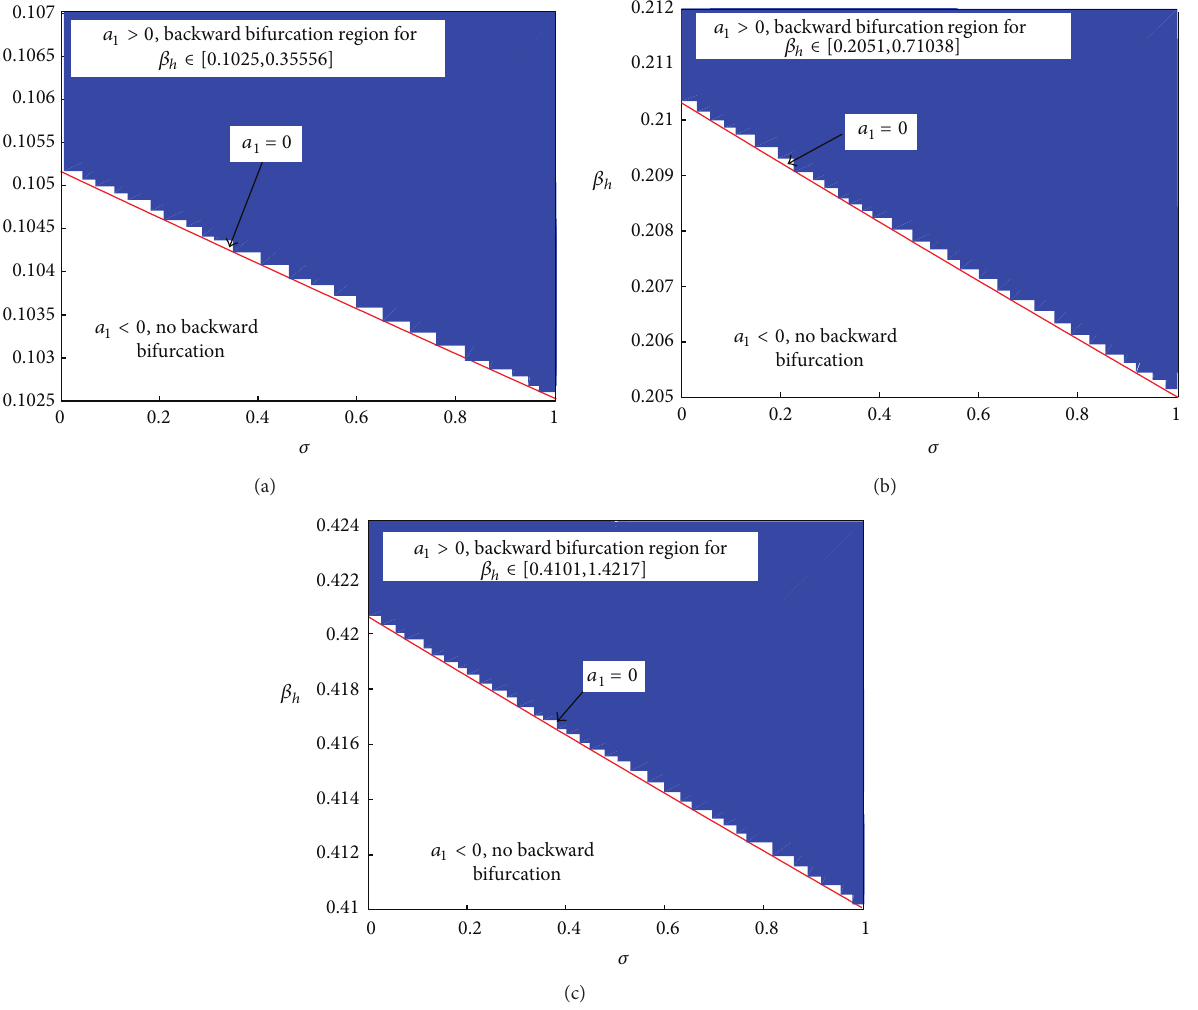
Figure 4: Backward bifurcation regions for the model (4) in the 𝜎 - 𝛽 ℎ parameter space corresponding to 𝜎 = 1 and various ranges of 𝛽 ℎ . Parameter values used are: Λ ℎ = 30, Λ 𝑣 = 24, 𝛿 ℎ = 0.2, 𝛾 ℎ = 0.0005, 𝜇 ℎ = 0.00004, 𝑏 = 0.4, 𝜇 𝑣 = 0.0.015, 𝛽 𝑣 = 0.09 . In (a) 𝜇 𝑣 = 0.05, ℜ 0 = 0.0014046 (backward bifurcation region for 𝛽 is 𝛽 ℎ ∈ [0.2051, 0.71083]) , and (c) 𝜇 𝑣 = 0.2, ℜ 0 = 0.0000087788 (backward bifurcation region for 𝛽 ℎ is 𝛽 ℎ ∈ [0.4101, 1.4217]) . With the above set of parameter values, 𝑎 1 > 0, 𝑏 1 > 0 , and ℜ 0 < 1